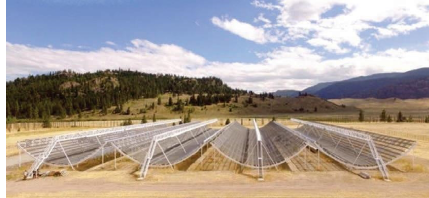
Figure 11: Canadian hydrogen intensity mapping experiment telescope (https://nrc.canada.ca/en/research-development/nrc- facilities/dominion-radio-astrophysical-observatory-research- facility).